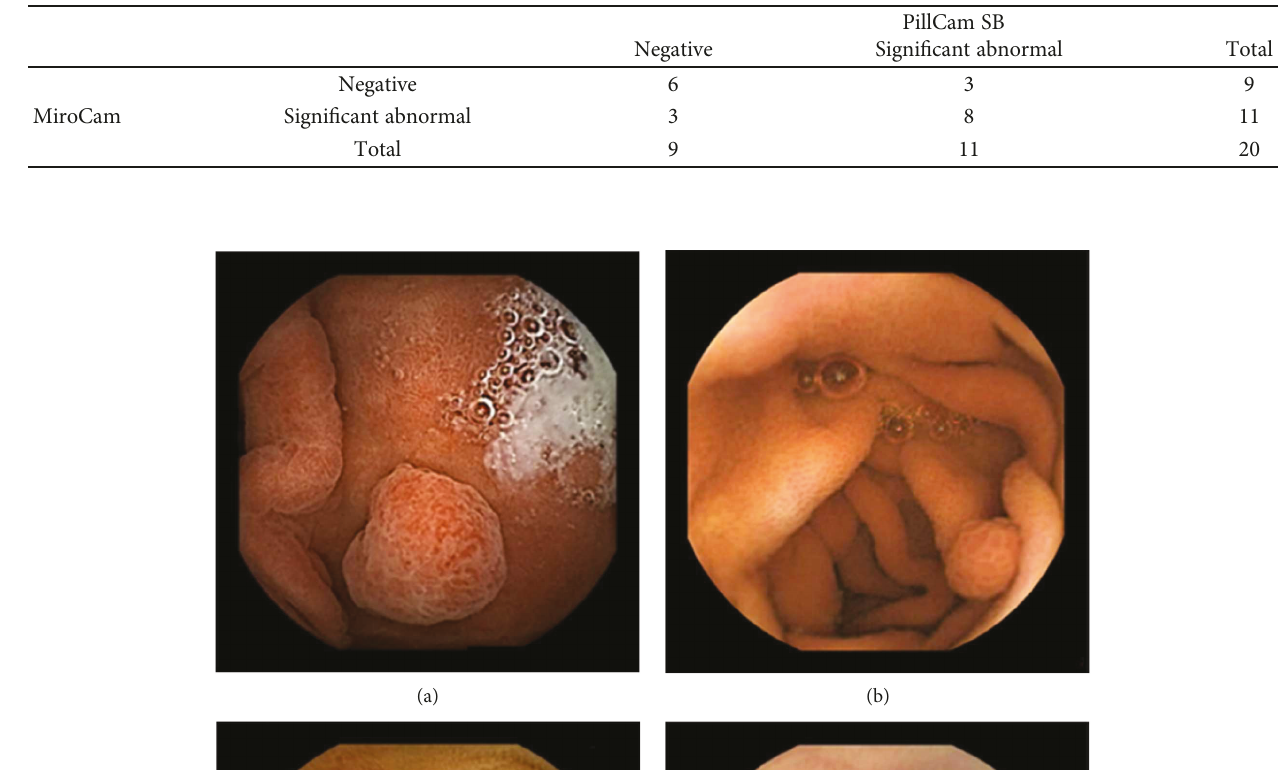
Table 4: Agreement between the MiroCam and PillCam SB3 results.